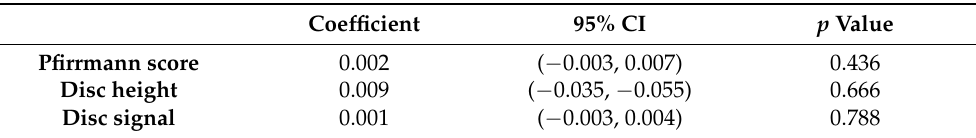
Table 3. Linear regression analysis of various parameters of transitional discs with age in type III